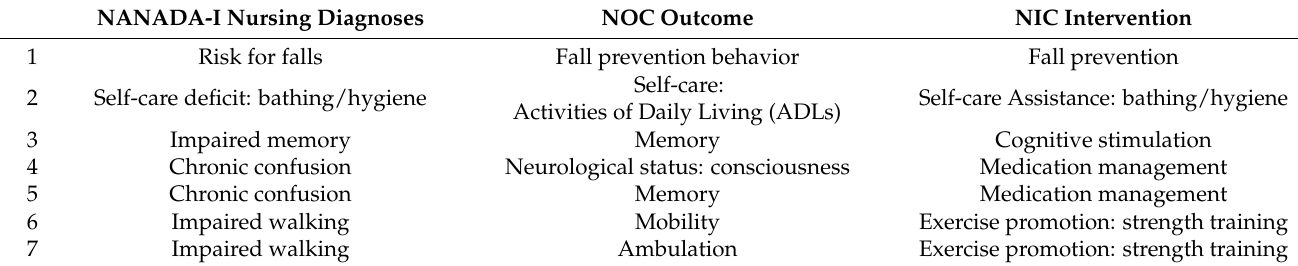
Table 4. 7 NNN linkages frequently used in